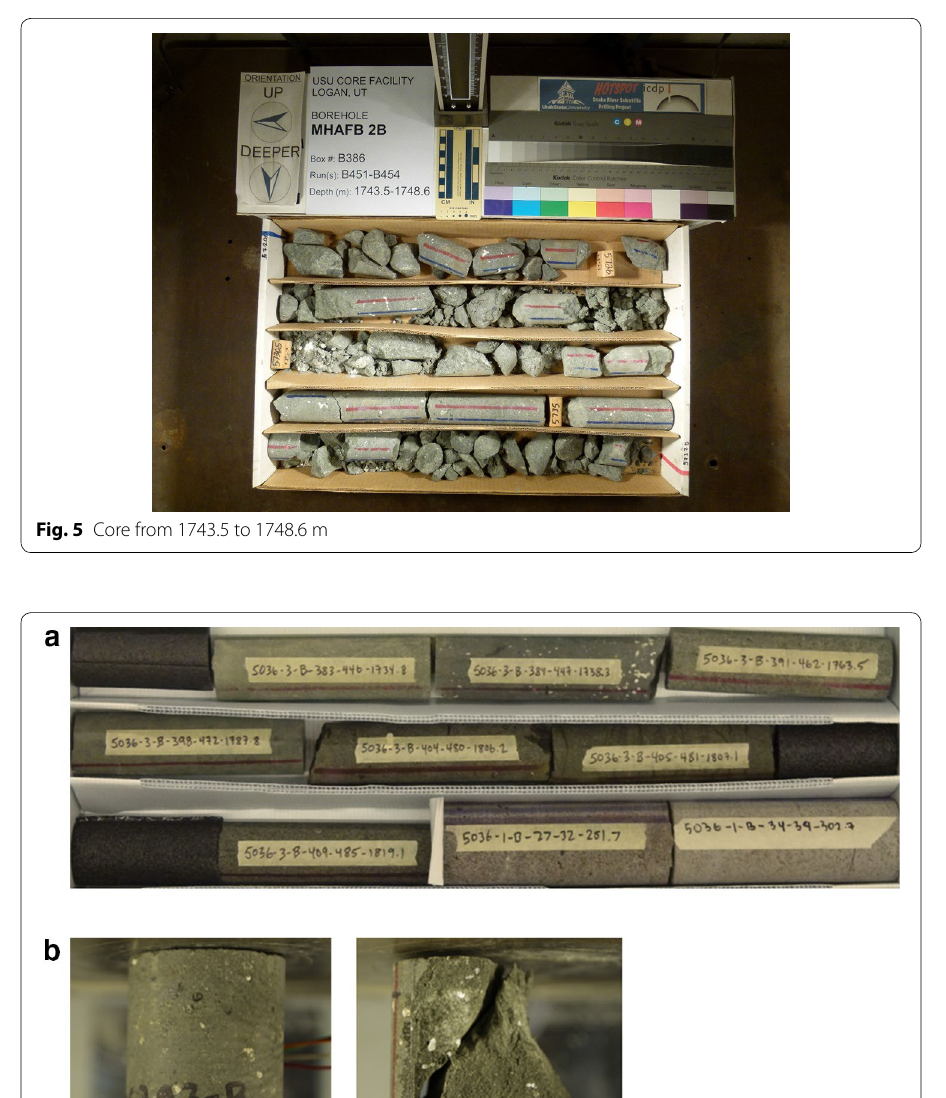
the bottom 10 m of the unit (Fig. 6a) with a montmorillonite/chlorite fill. The samples failed catastrophically (Fig. 6b) near the bottom of the unit. Unit 2 is the shallower ductile unit. It lacks fractures. The core samples show fine- grained, highly altered basalt with minor silica-filled voids (Fig. 7a). The presence of smectite clays (saponite) indicates hydrothermal alteration, and the presence of feldspar (labradorite) and other silicates may indicate the preservation of original material that has been reworked and redeposited in this unit. Some samples show reworked basal- tic sediments that appear to have been deposited in a secondary environment from their original volcanic deposition. The stress–strain relationship shows that the samples exhibited ductile deformation until a fracture developed late in the experiment (Fig. 7b).